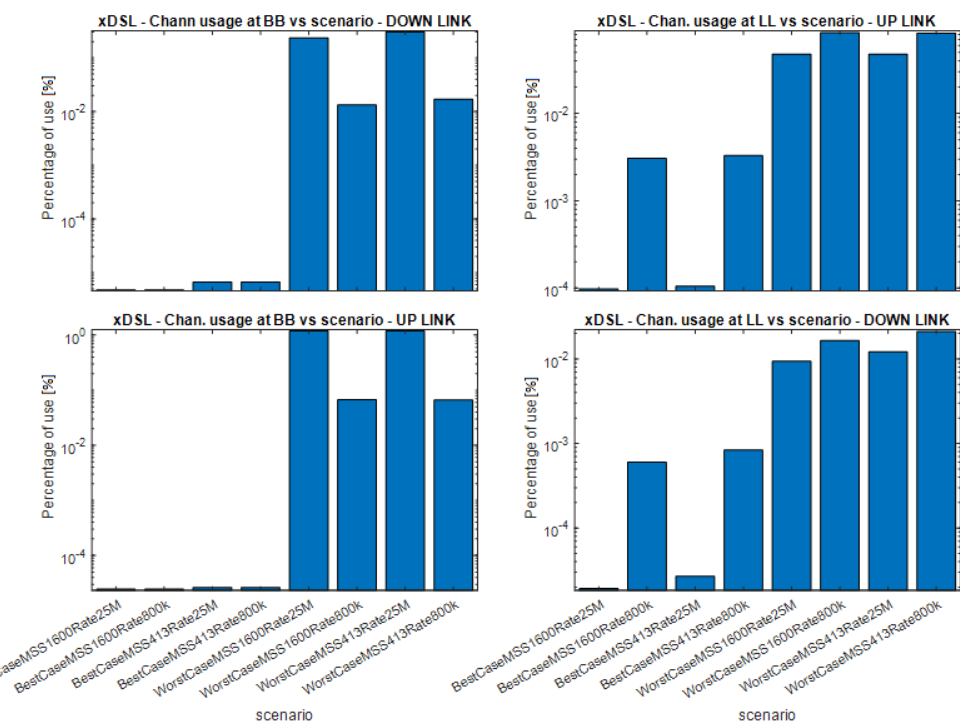
Figure 10. Usage for the Local-Loop (LL) and Back-Bone (BB) on the up and down link for Scenario C.